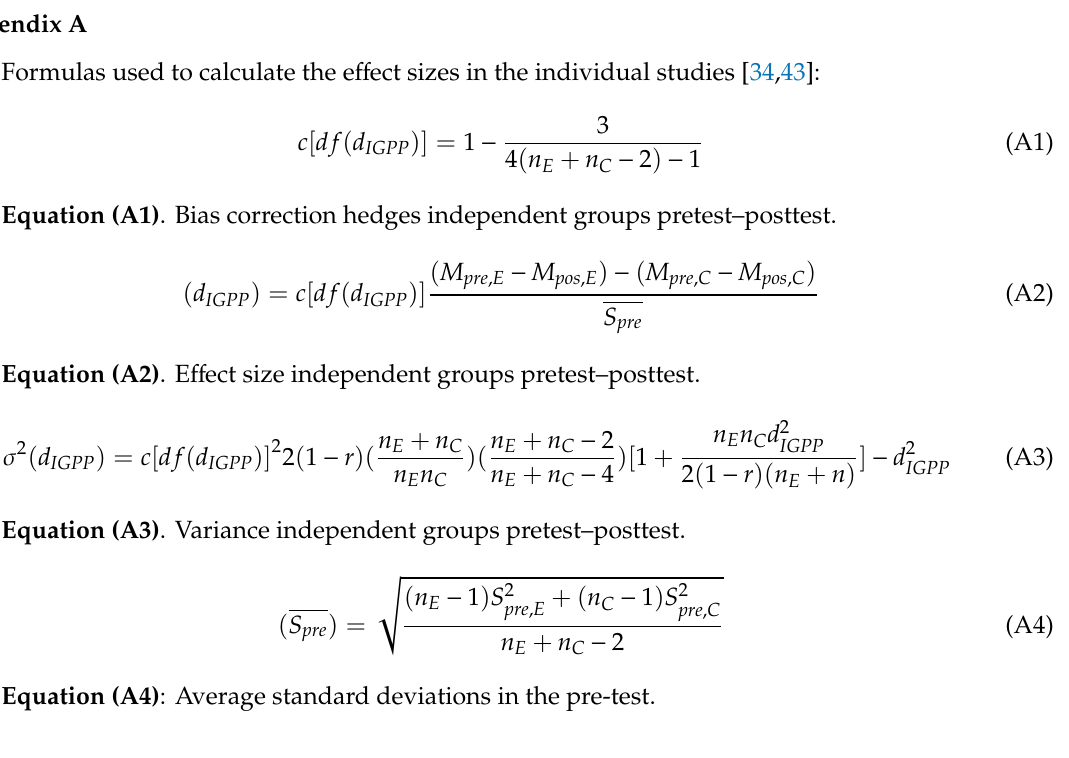
Table S1: Description of the studies included in the meta-analysis. Table S2: Summary of the quality of the reviewed studies using the Cochrane Risk of Bias Tool. Table S3: Sensitivity analysis regarding moderating variables (positive and negative